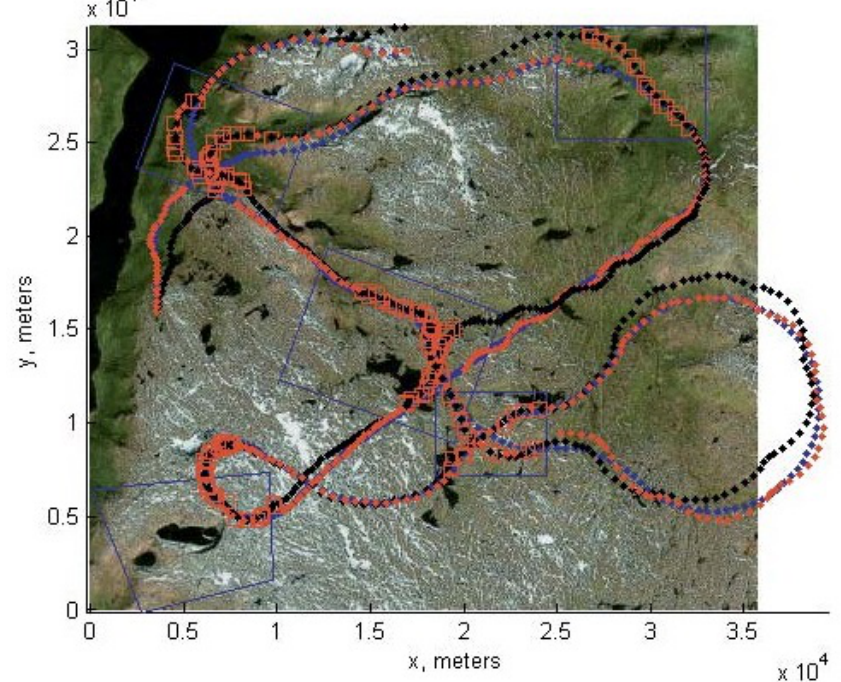
Figure 6. Blue dots corresponds to the reference trajectory and black dots to the real path. Blue squares show the localization of the terrain areas corresponding to the template images, and red squares show the moments where the estimates of the UAV positions have been obtained and assumed to be reliable according to the robust RANSAC algorithm described in Section